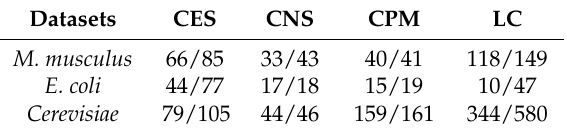
Table 6. Total number of significant categories with p -value ≤ 0.001 predicted by each algorithm.